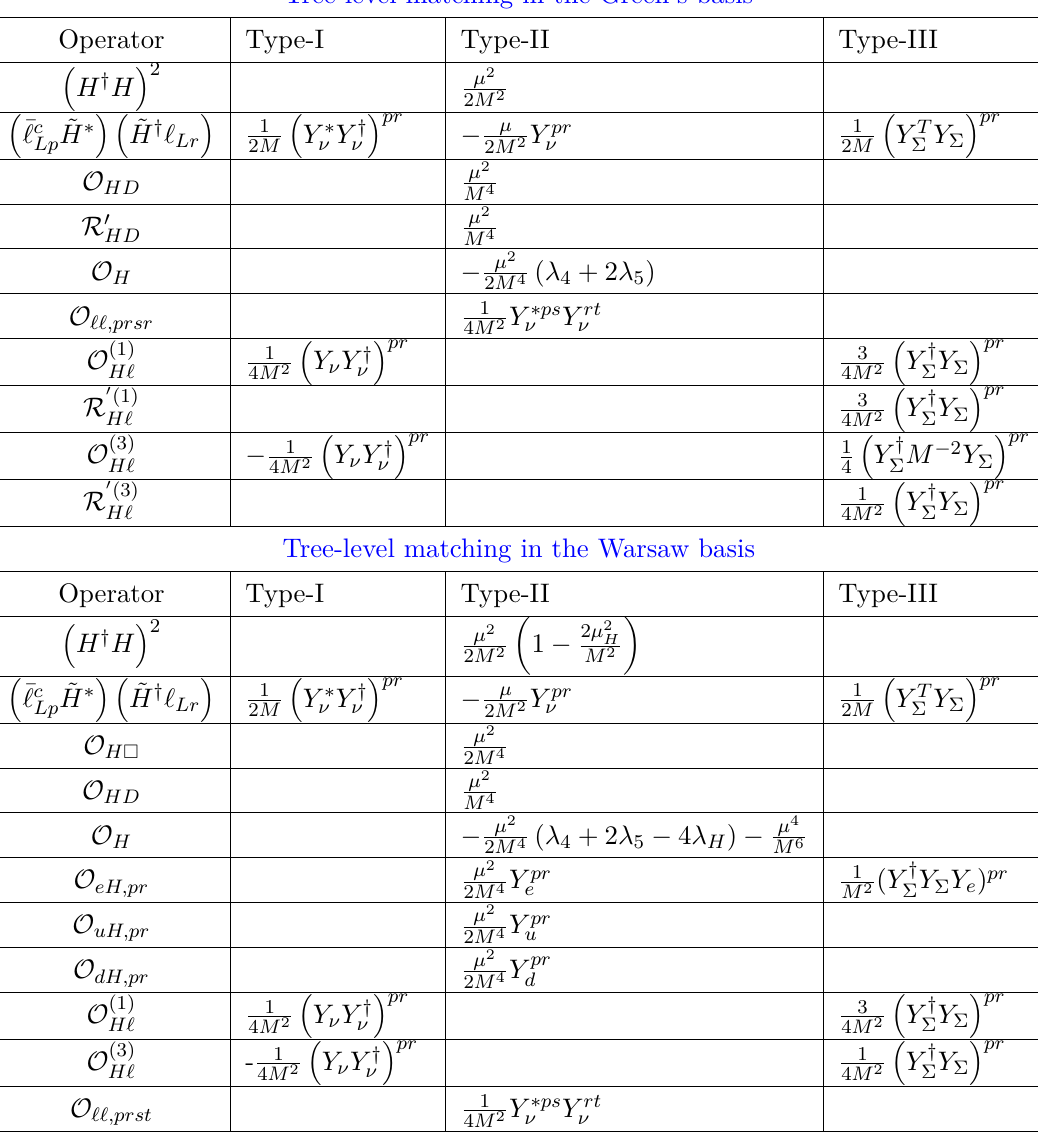
Table 1 . Tree-level matching for the three seesaw models using the functional method. Results are presented in both the Green’s and the Warsaw bases. Empty cells imply the specific model does not generate the corresponding operator. The specific forms of the dimension-6 operators are listed in table